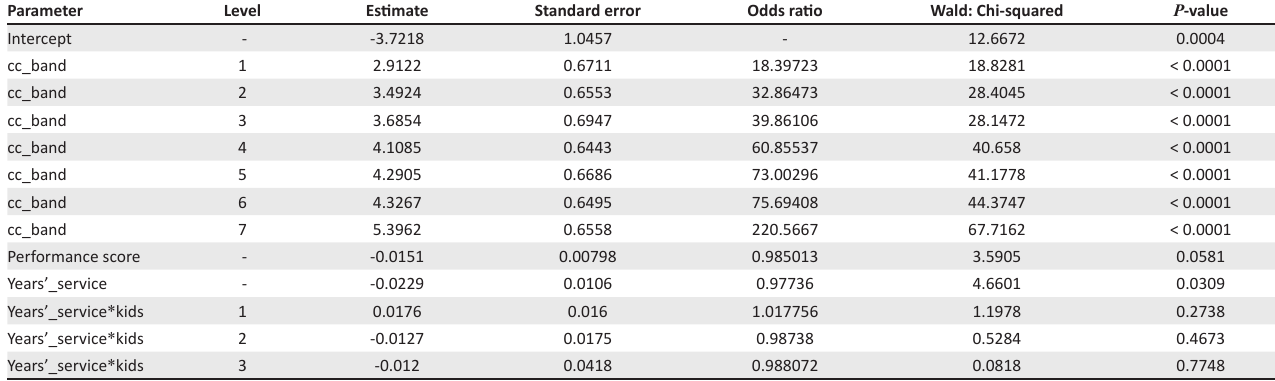
TABLE 5: Analysis of maximum likelihood estimates. Parameter